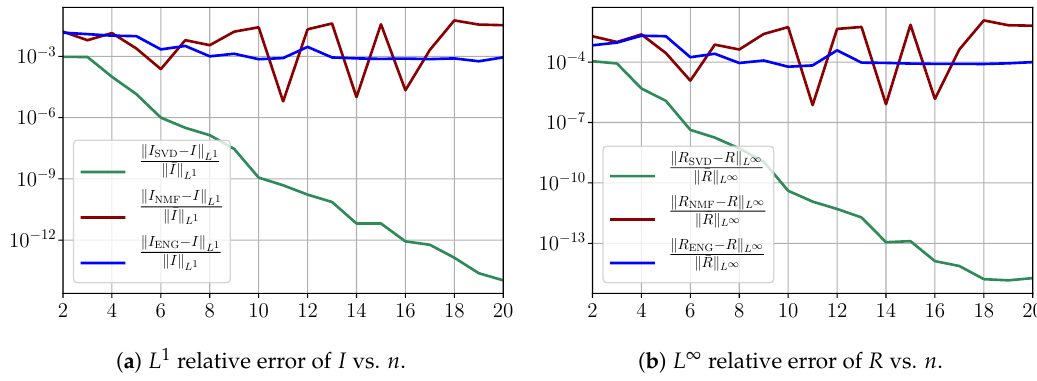
Figure A4. Study of sampling errors: Fitting errors of functions β and γ from training sets and . B tr G tr